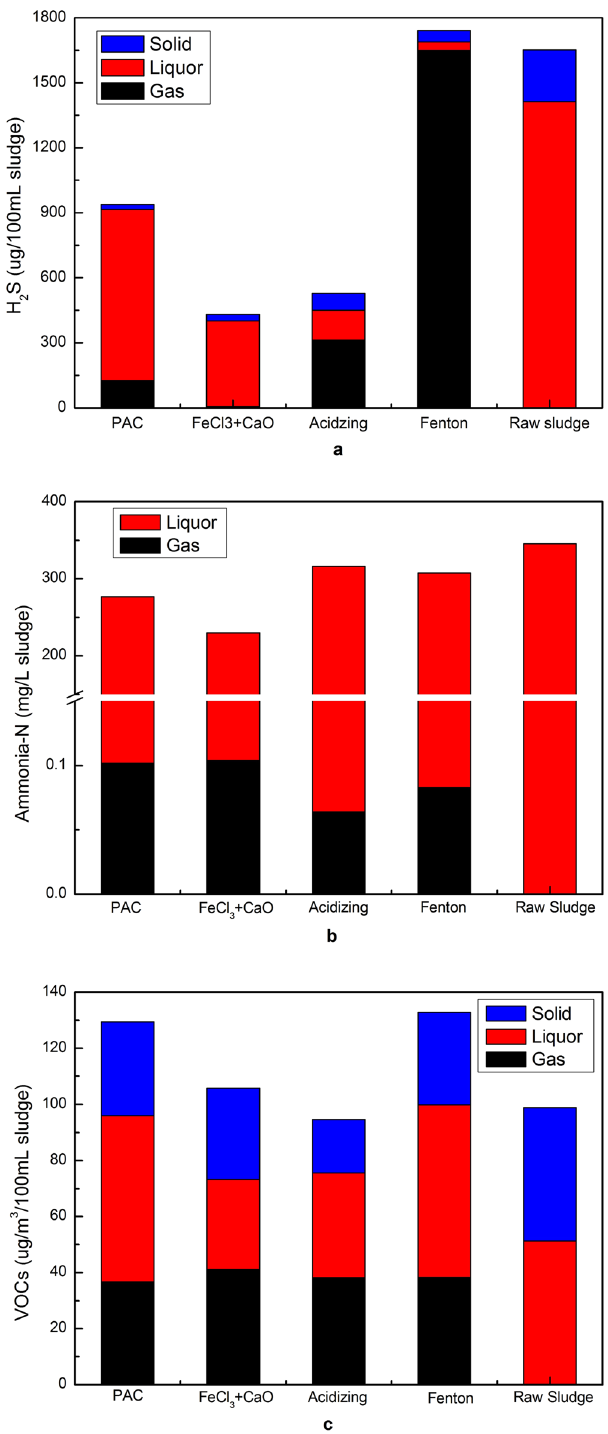
Figure 7. Mass balance of odorous pollutants under different conditioning processes ( a ) H 2 S; ( b ) Ammonia-N; ( c )